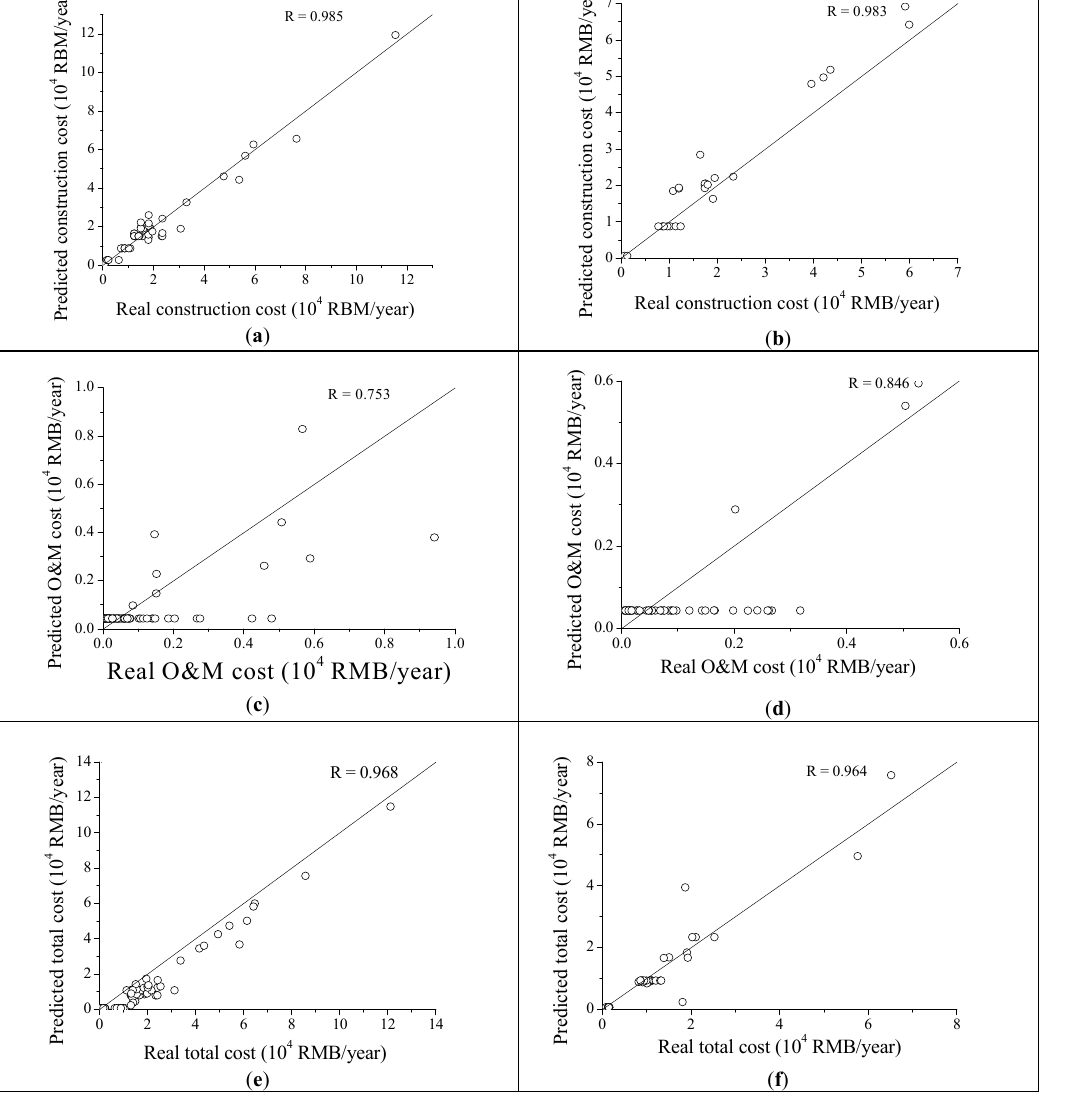
Figure 5. ( a ) Comparison of training dataset between real construction cost and predicted construction cost. ( b ) Comparison of testing dataset between real construction cost and predicted construction cost. ( c ) Comparison of training dataset between real OMC and predicted OMC. ( d ) Comparison of testing dataset between real OMC and predicted OMC. ( e ) Comparison of training dataset between real total cost and predicted total cost. ( f ) Comparison of testing dataset between real total cost and predicted total cost.